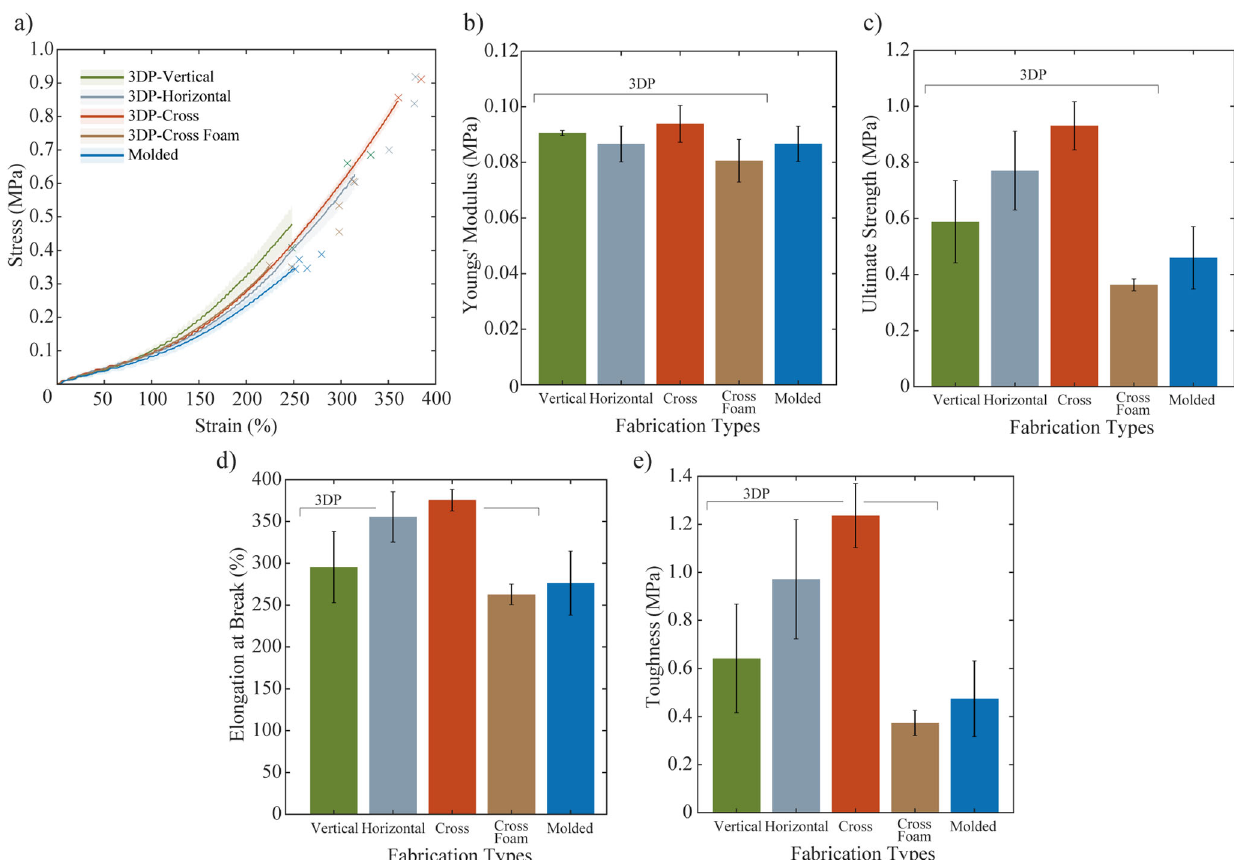
Fig. 6 Mechanical properties of the printed silicone and polymer foam in comparison with molded counterparts. a Stress – strain curve for 3D printed and molded dumbbell test pieces. Individual “ x ” marks represent break points per sample. 3D printed samples categorized by their print directions: vertical, horizontal, and cross (Supplementary Fig. 8) for silicone prints and only cross for foam prints. Shaded regions represent one standard deviation. b Young ’ s modulus comparison based on fabrication type and print direction. Ultimate strength ( c ), elongation at break ( d ), and toughness ( e ) comparisons based on fabrication type and print direction. Error bars represent one standard